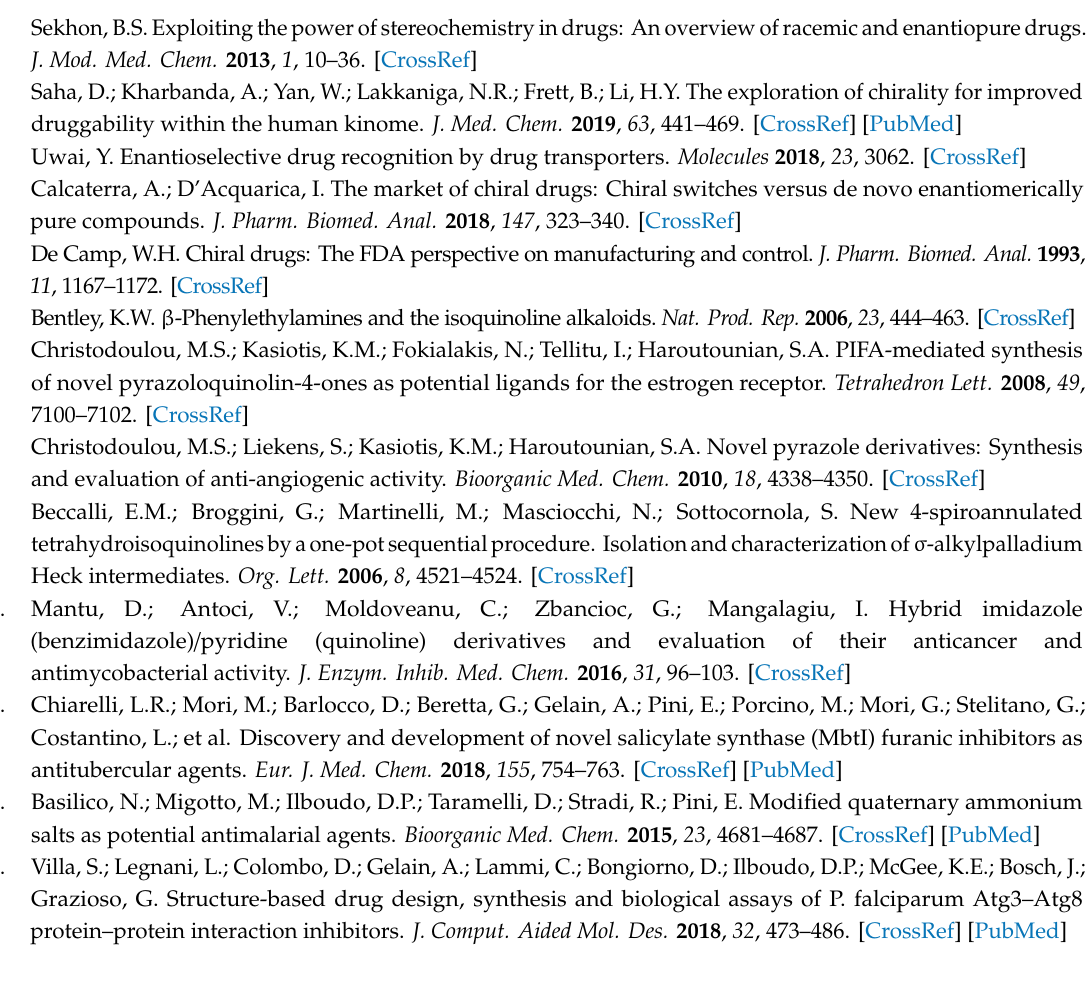
Supplementary Materials: The following are available online. Figure S1: E ff ect of compound ( R )-5a on the electrophoretic mobility of supercoiled DNA. Figure S2: E ff ect of compound ( R )-5a on the relaxation of supercoiled pBR322 DNA by human recombinant topoisomerase I or II, Figure S3: Source of